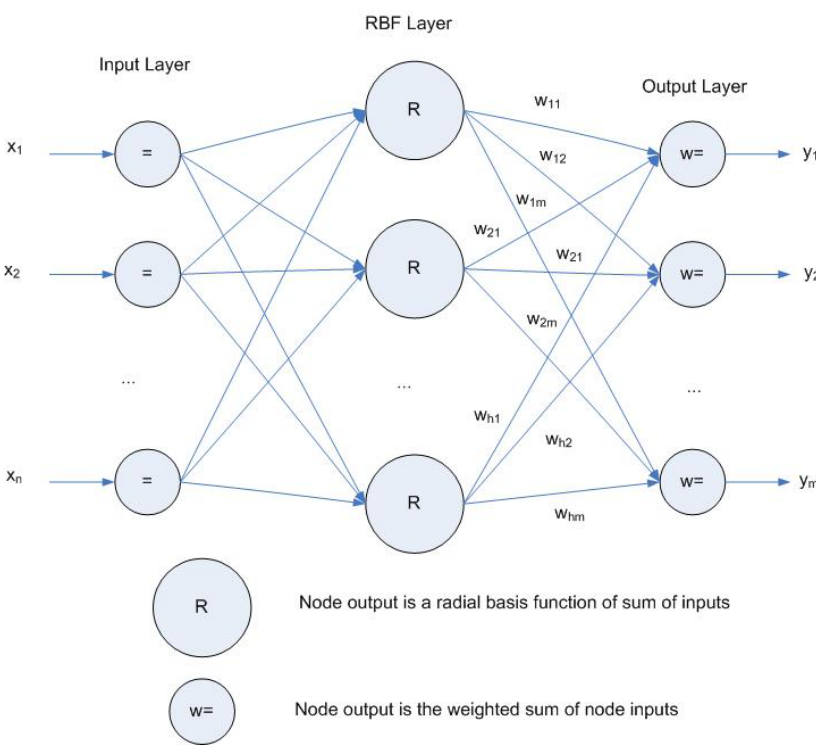
Figure 2. RBF network